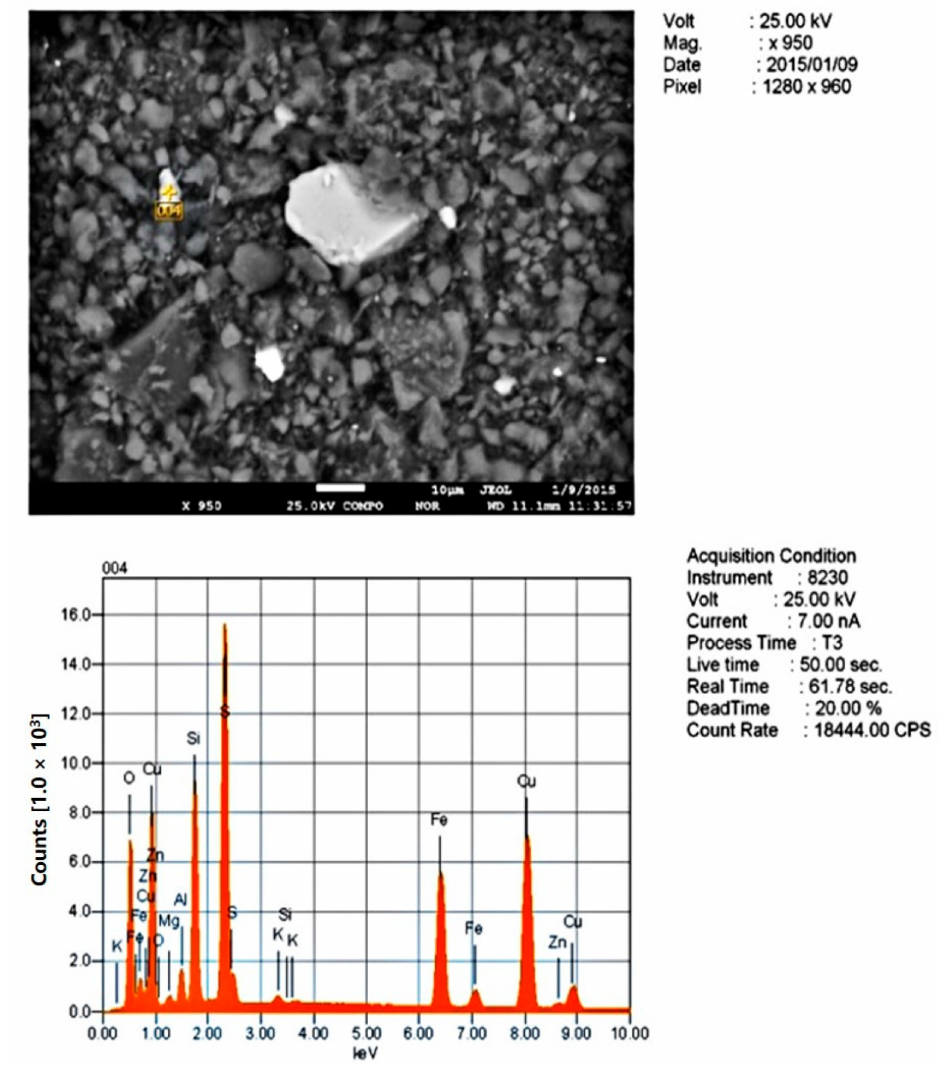
Figure 3. Analysis of the original copper–molybdenum ore on a JXA-8230